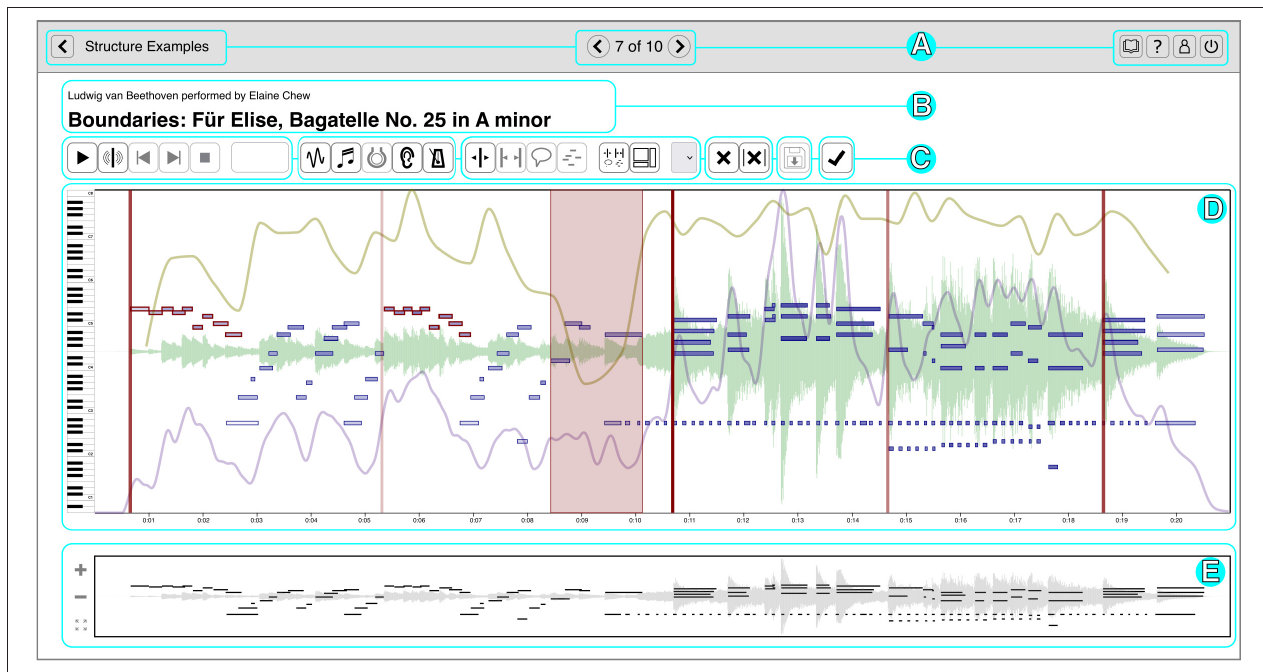
FIGURE 1 | The main CosmoNote interface showing an annotated excerpt of Beethoven’s Für Elise. The cyan rectangles highlight the different elements: (A) Navigation bar for the collection and account options; (B) Names of the piece, performer, composer; (C) Audio controls, annotation types, and other control buttons; (D) Visualization pane—annotations are displayed in shades of red on top of the waveform (pale green), piano roll (shades of blue), loudness (mauve), tempo (olive), and harmonic tension (shades of brown, not shown); and (E) Contextual zoom. See Supplementary Video 1 in the Supplementary Materials to hear the music presented in this Figure.